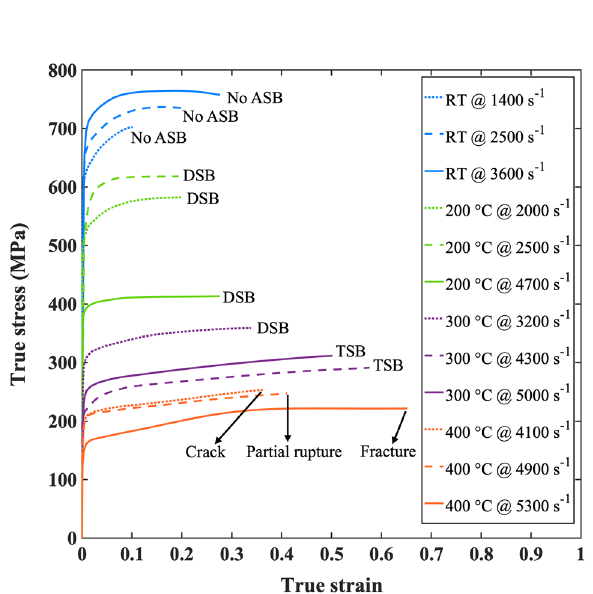
Fig. 16 Flow stress behavior with respect to microstructure evolu-